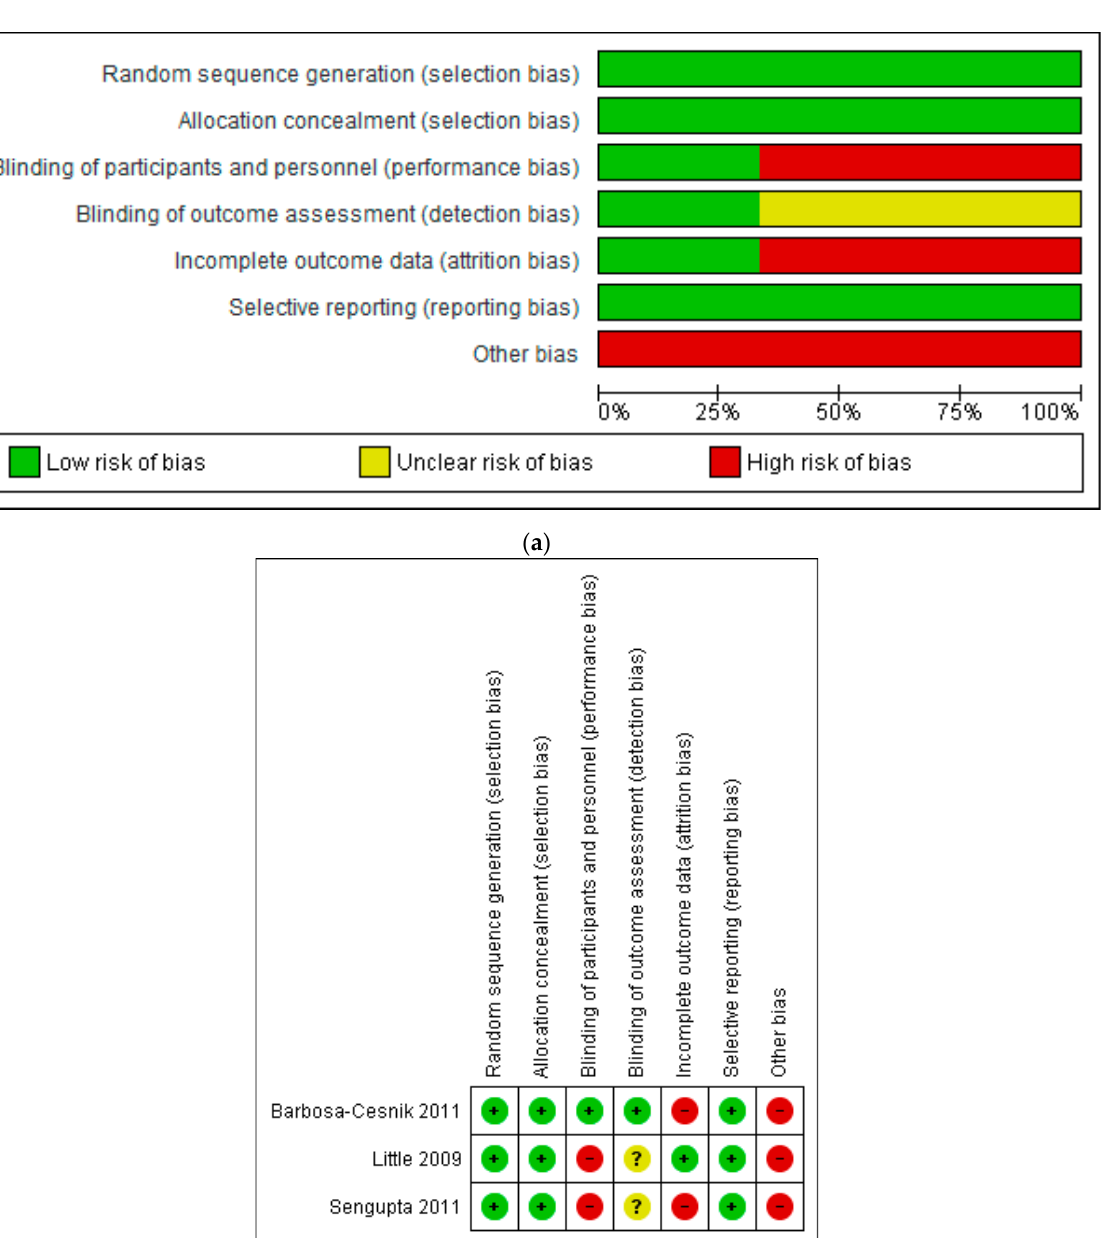
Figure 2. ( a ) Risk of bias graph: review authors' judgements about each risk of bias item presented as percentages across all included studies. ( b ) Risk of bias summary: review authors' judgements about each risk of bias item for each included study.